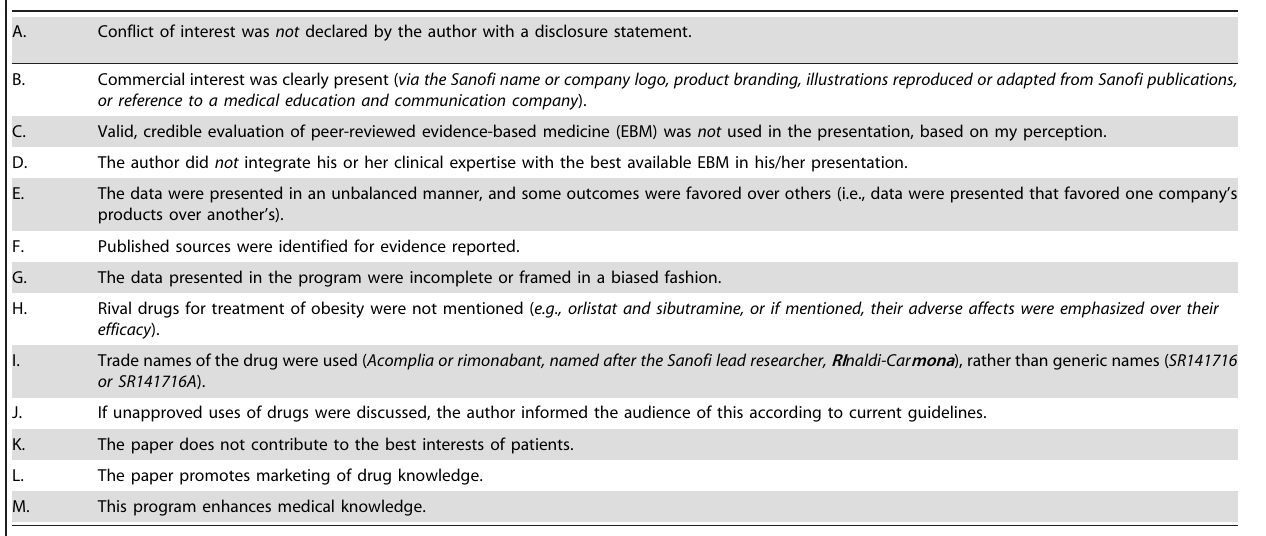
Table 1. Thirteen questions (A to M) comprising the Takhar instrument [56] for monitoring bias in Continuing Medical Education ( with adaptations applied to rimonabant review articles in italics